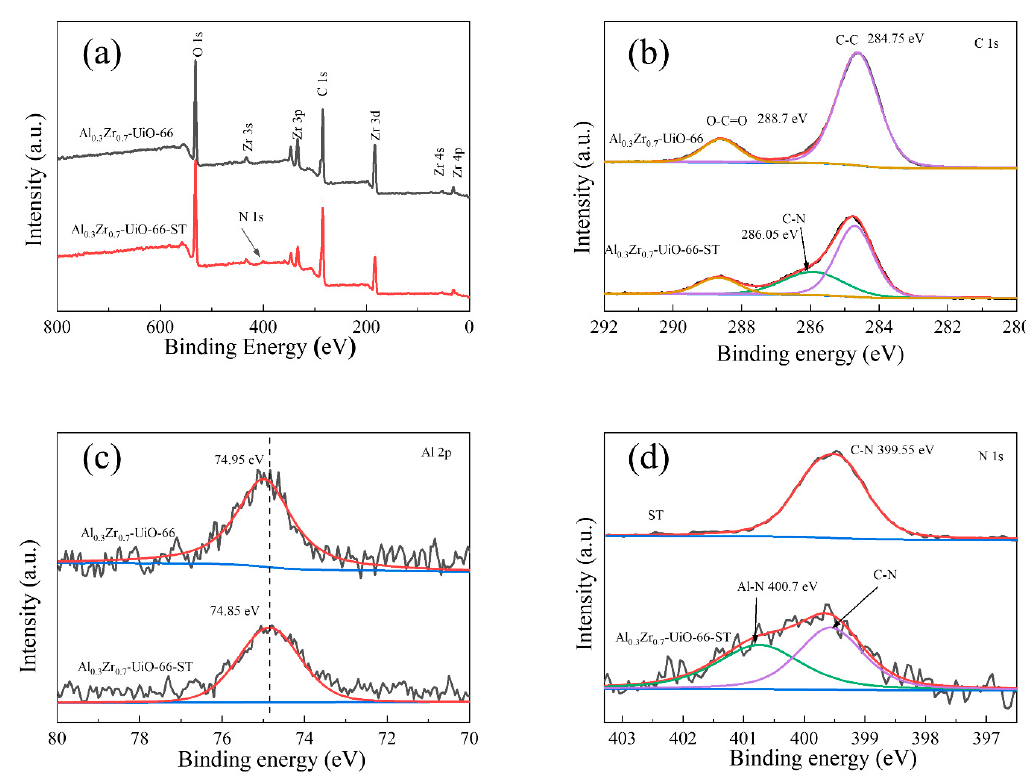
Figure 11. XPS analysis of Al 0.3 Zr 0.7 -UiO-66 before and after adsorption of ST: ( a ) XPS spectra, ( b ) XPS spectra of C 1s, ( c ) XPS spectra of Al2p, and ( d ) N1s spectra of ST and Al 0.3 Zr 0.7 -UiO-66 after the adsorption of ST.